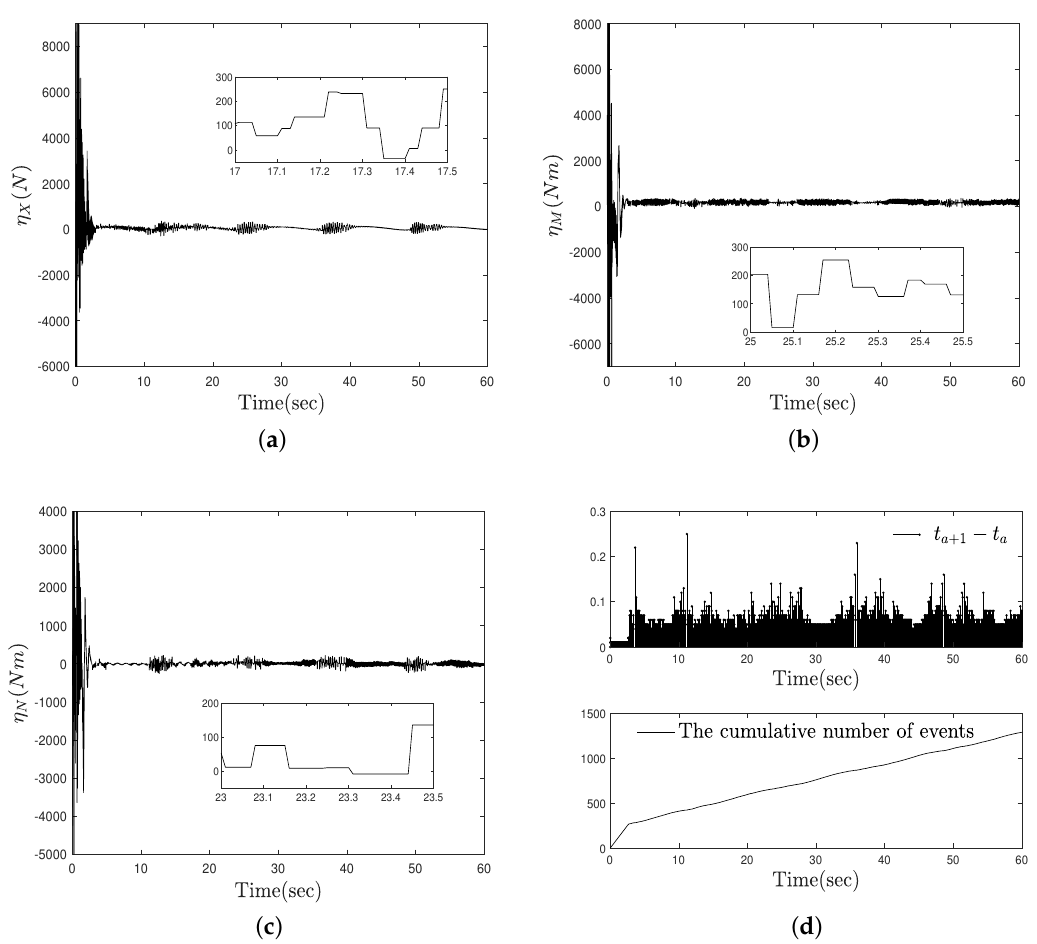
Figure 19. Event-driven control laws, inter-event times, and the cumulative number of events of the proposed approach for Scenario 3 ( a ) η X ( b ) η M ( c ) η N ( d ) inter-event times and the cumulative number of